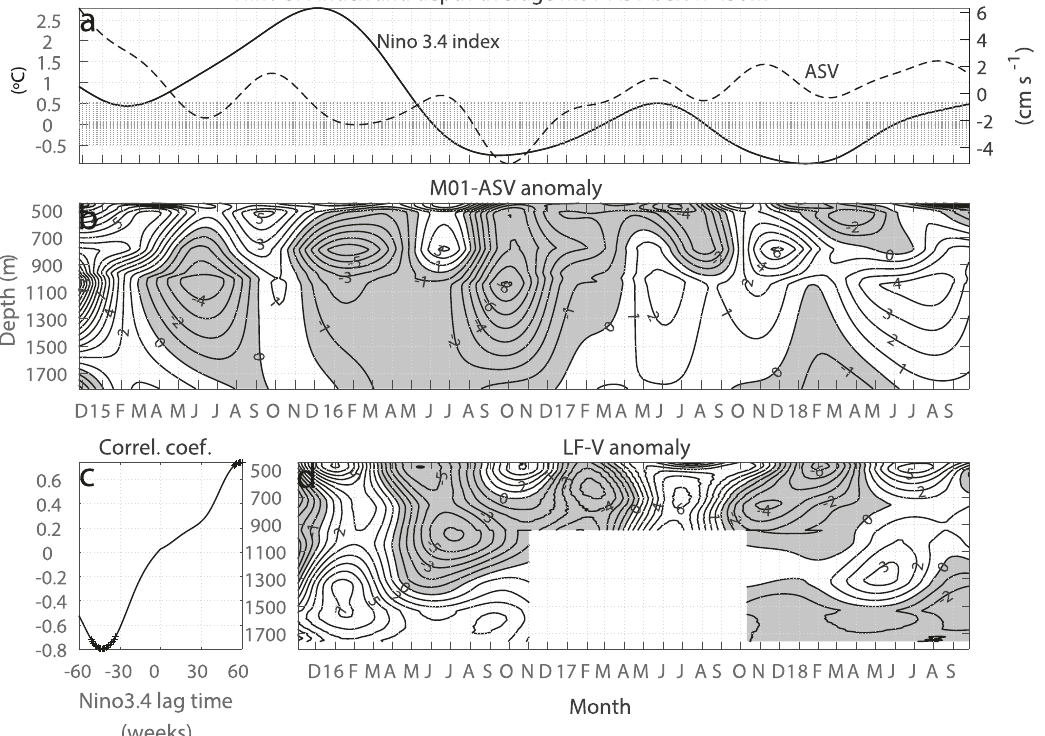
Fig. 4 Interannual variations. Maluku Sea intermediate WBC anomalies ( a , b ), showing signi fi cant lead and lag correlations with Niño3.4 index ( c ), and co- variability with the currents through the Lifamatola Passage ( d ). The black Crosses in ( c ) represent the correlation coef fi cient above 95% signi fi cance level. Units are cm s − 1 for velocity and °C for Niño3.4 index. Contour interval is 1 cm s − 1